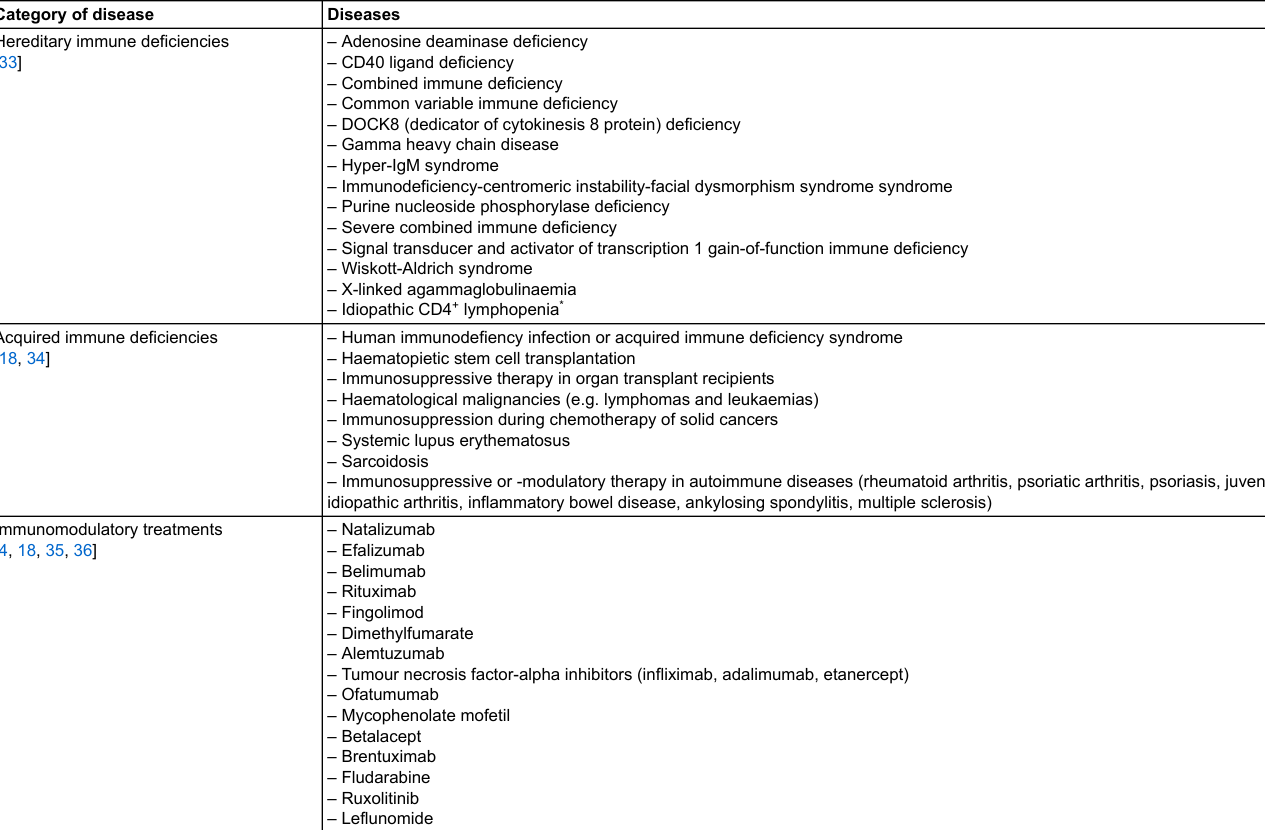
Table 1: Hereditary and acquired diseases and immunomodulatory/- treatments associated with a risk of PML or other JCPyV-induced CNS infectious diseases. Category of